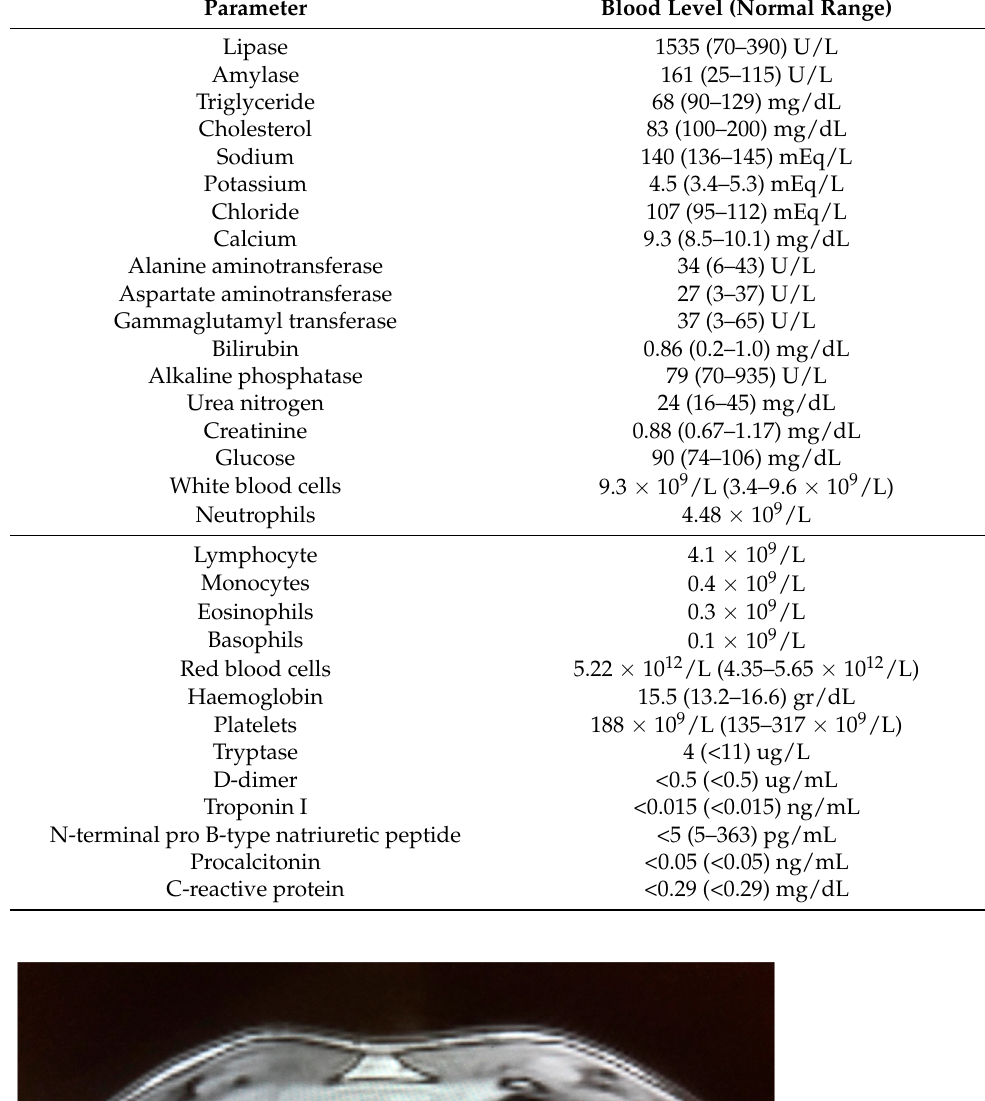
Table 1. Laboratory analyses on hospital admission.